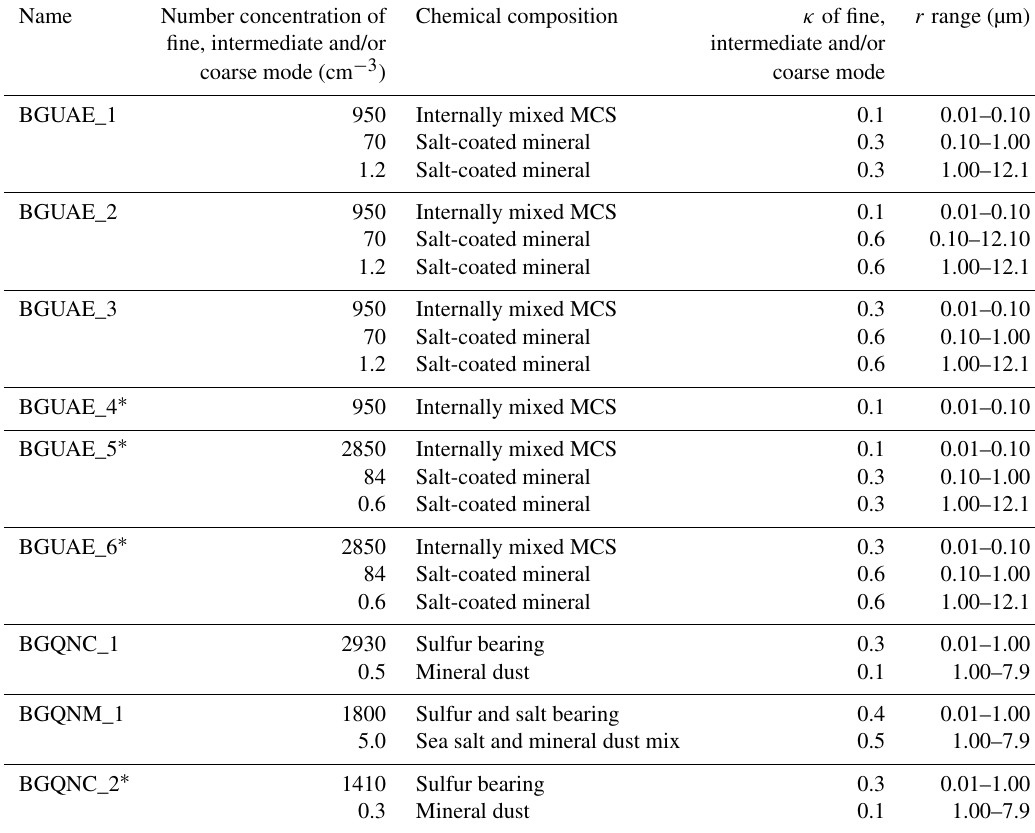
Table 1. Number concentration (cm − 3 ) and chemical composition of the background aerosol particles observed in SPEC UAE and QCSRP. The hygroscopicity parameters for intermediate and coarse modes in the BGUAE cases were estimated based on the chemical composition observed by Semeniuk et al. (2014). The number concentrations are taken from the SF4 case in Wehbe et al. (2021). BGUAE means background aerosol observed in the SPEC UAE campaign. BGQNC and BGQNM mean background aerosol in continental and maritime air masses, respectively, in QCSRP. ∗ indicates that the observed size distributions are modified for the sensitivity test.